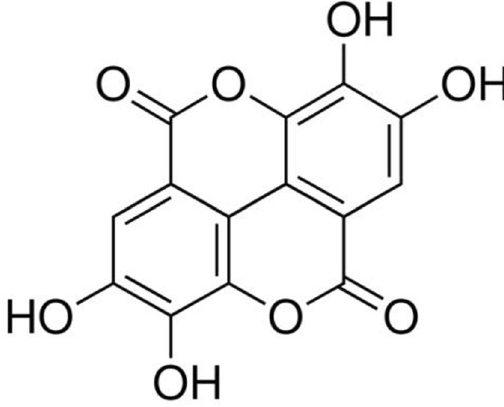
Figure 1. Chemical structure of